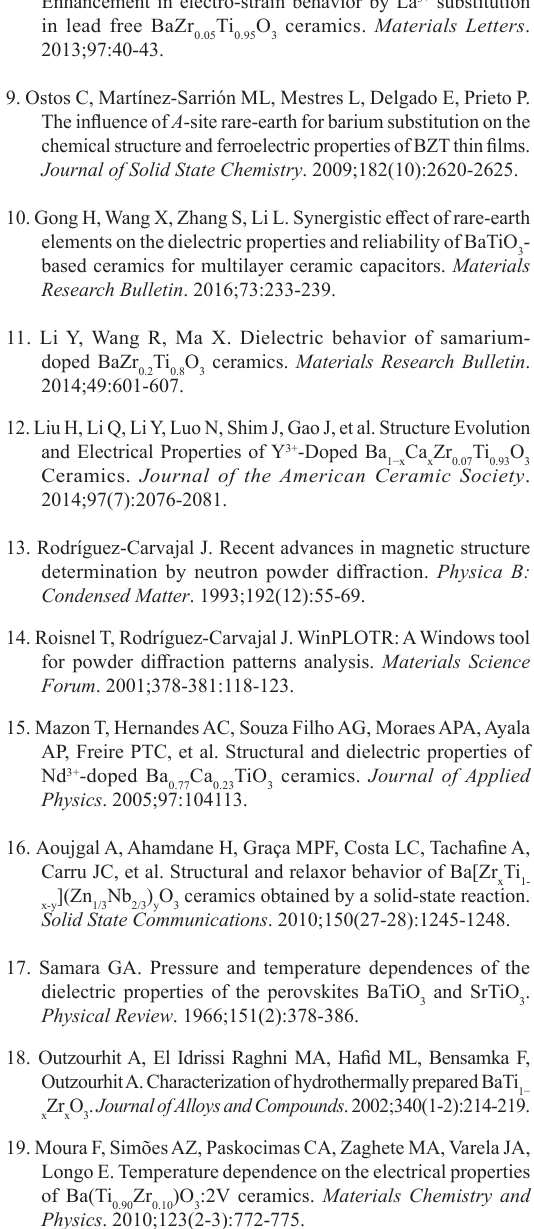
Figure 10: Temperature dependence of dielectric loss of BZT10 + x Yb O ceramics sintered at 1300 o C/2 h 2 3